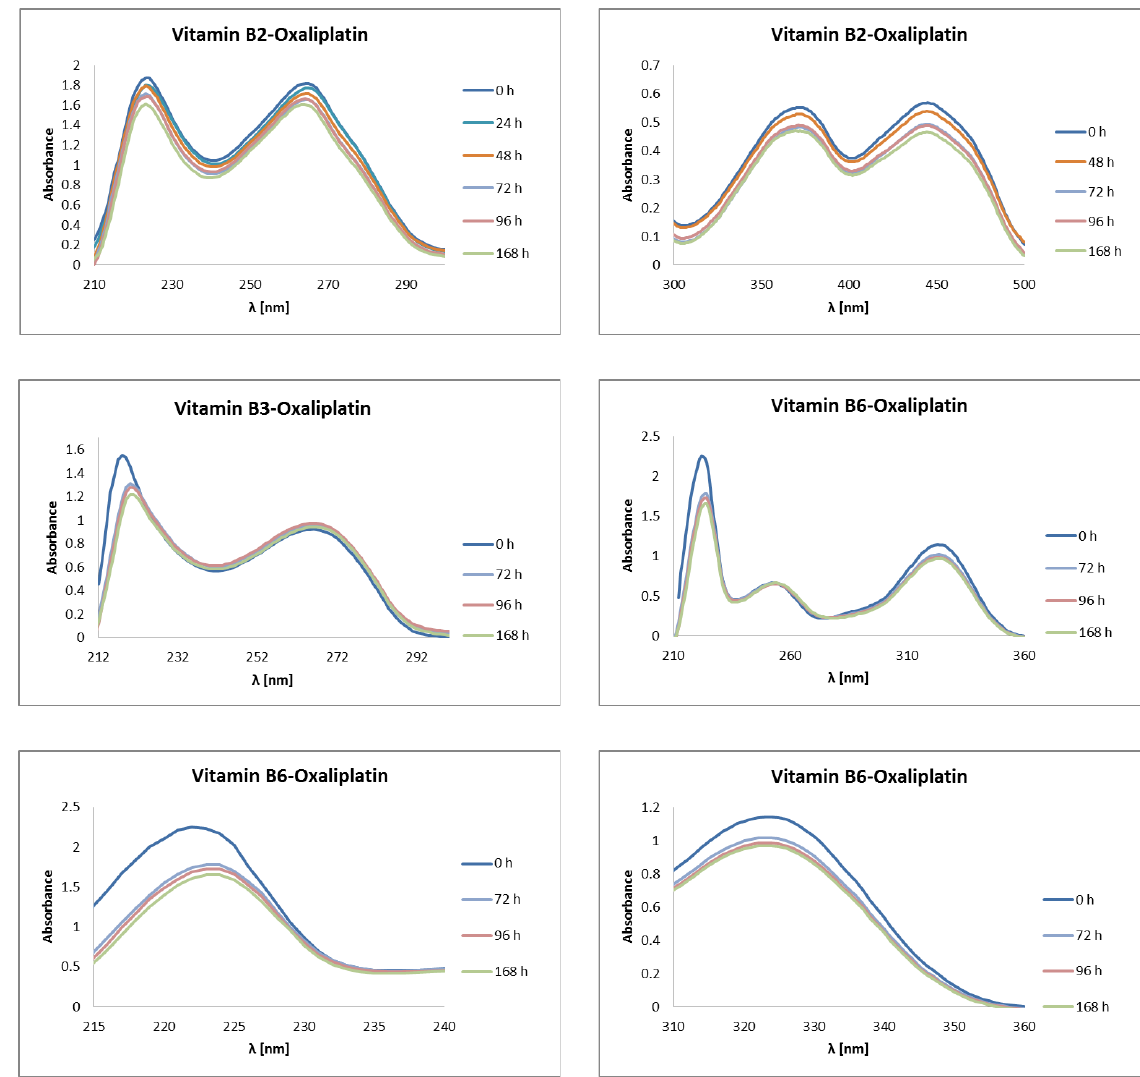
Figure 7. UV-Vis absorption spectra of vitamins from the B group and Oxaliplatin mixture in an incubation buffer (1 mmol L −1 phosphate buffer, 4 mmol L −1 sodium-chloride, pH 7.4). 0h shows incubation buffer (1 mmol L − 1 phosphate buffer, 4 mmol L − 1 sodium-chloride, pH 7.4). 0h